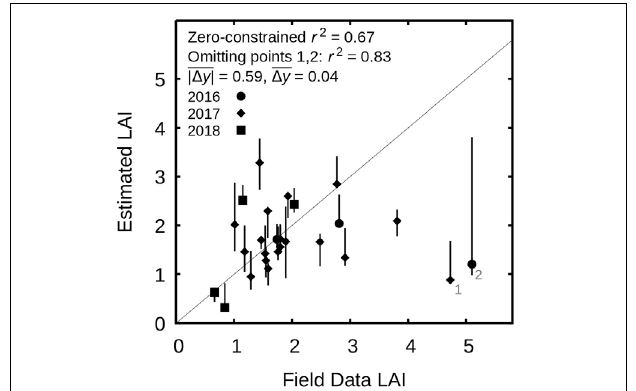
FIGURE 6 | Scatterplot of LAI field data vs. image derived year-median LAI for the year each data point was collected (shown in the key, n = 26). Grey line is 1:1, error bars are the minimum and maximum LAI value found in the 5 × 5 pixel window centred on the pixel containing the field data point. Points labelled 1 and 2 are mentioned in the text and shown in detail in Figure 7